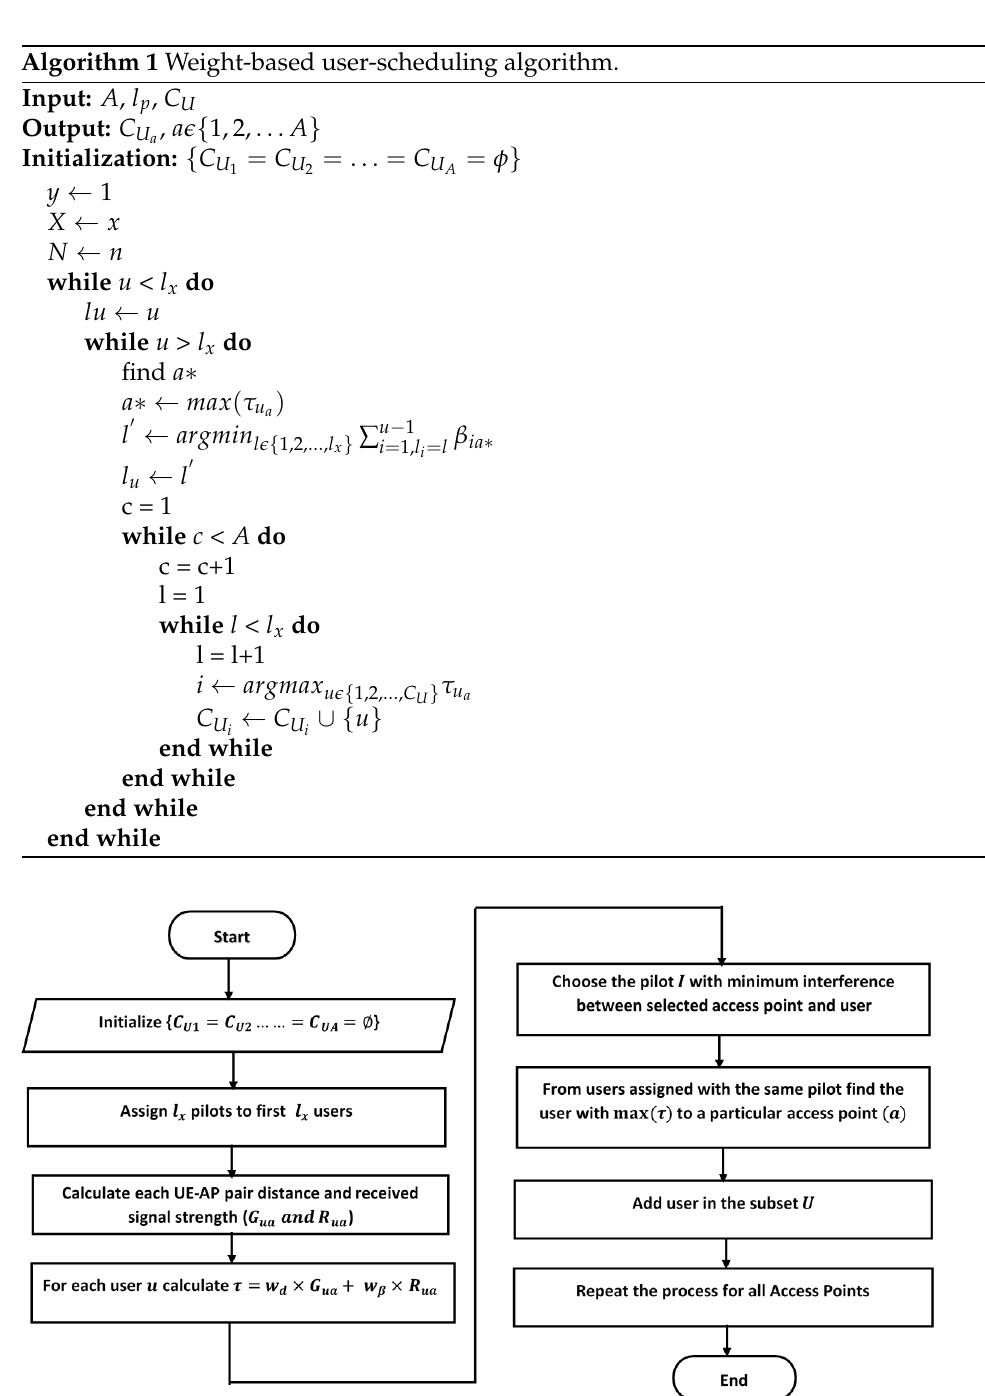
Figure 3. Flowchart of weighted user-scheduling